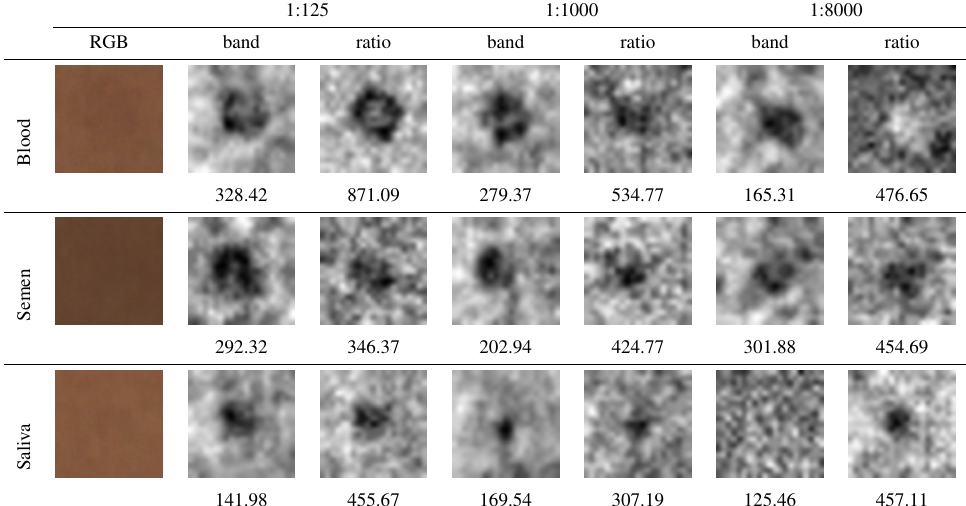
and ratio I ( λ , identified by maximal Fisher’s ratios F λ i i ,λ j )